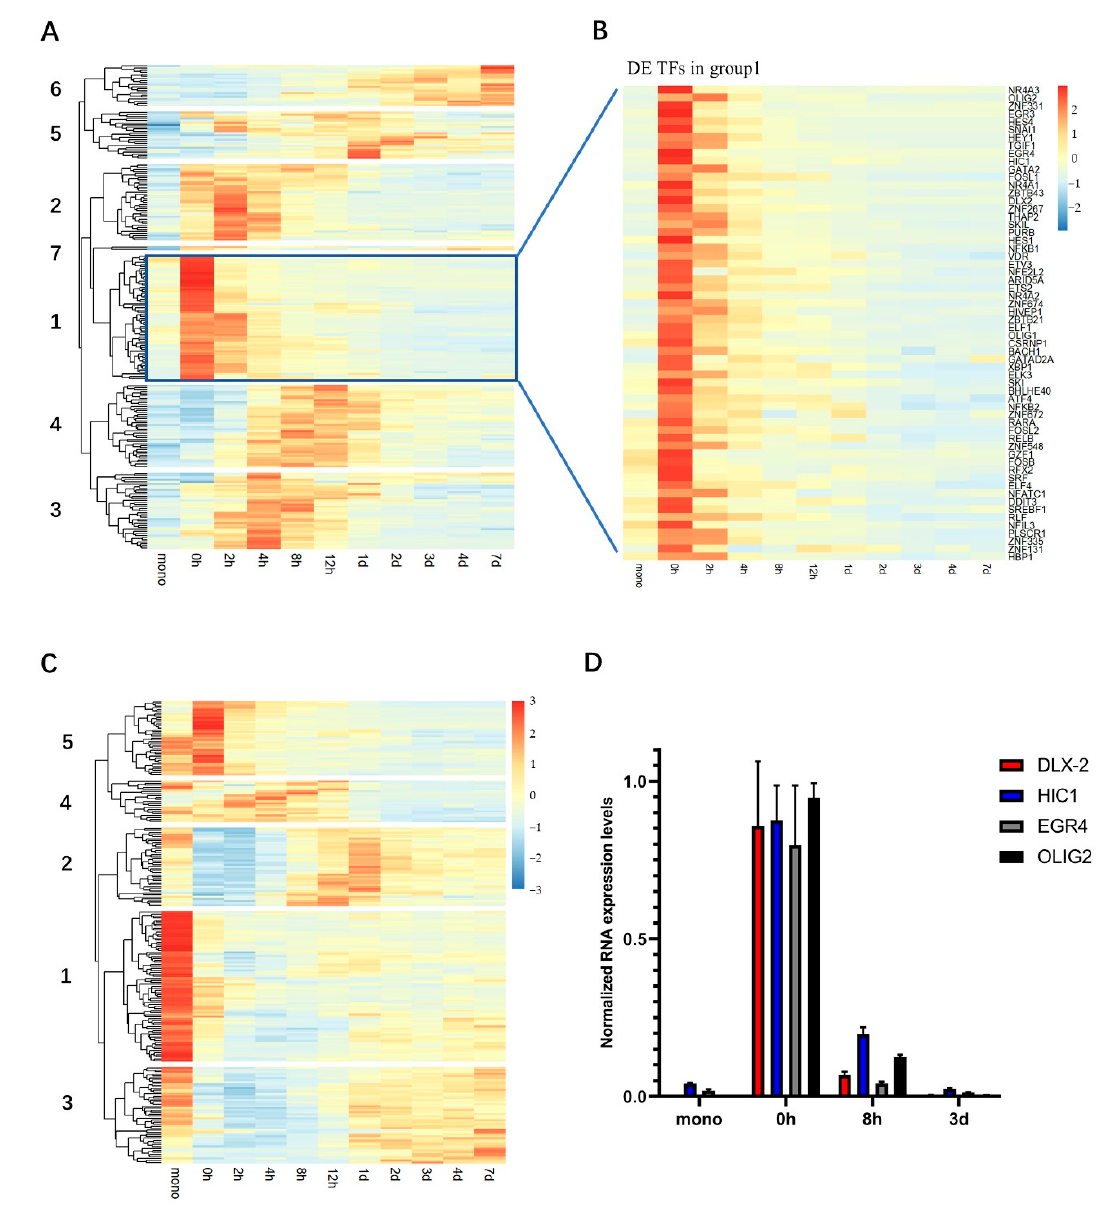
Figure 2. Hierarchical clustering reveals groups of the DE TFs with similar expression dynamics. ( A ) There are seven groups of up-regulated DE TFs. ( B ) Expanded view of the group 1 up-regulated DE TFs, ranked by log2(FC) (TPM). ( C ) There are five groups of the down-regulated DE TFs. ( D ) Validation of the temporal differences from the select DE TFs using qRT-PCR. The relative RNA expression levels are based on the expression of actin, and then normalized to their maximally ob- served level.